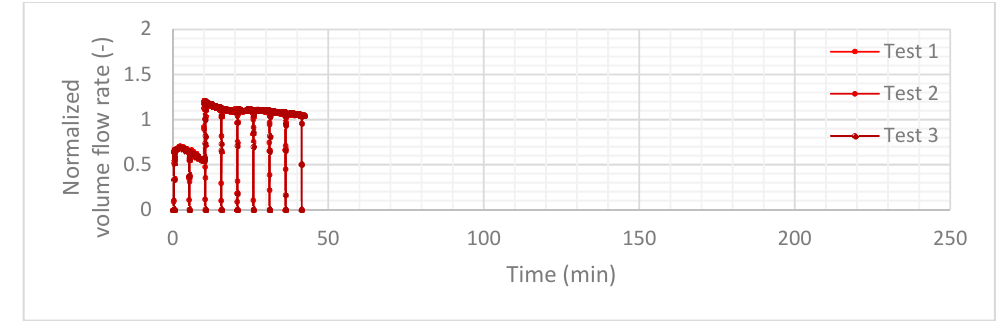
Figure A5. Normalized air volume flow rate trend at a thermostatic temperature of 0 °C during the two repetitions.